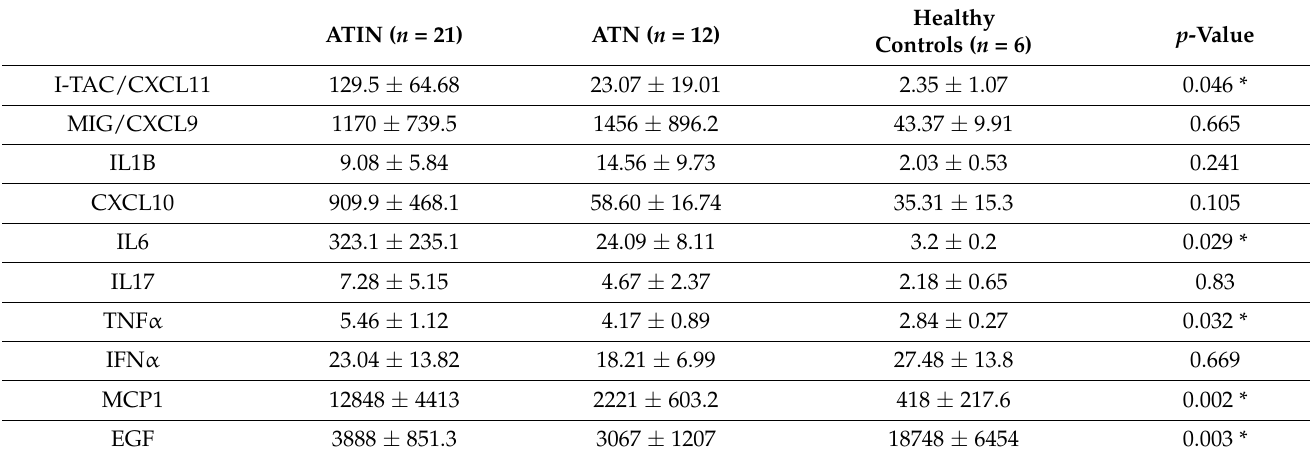
Table 2. ANOVA test comparing the urinary concentration of the evaluated cytokines in patients with ATIN, ATN, and healthy controls. * Statistically significant differences. ATIN—acute tubulointerstitial nephritis; ATN—acute tubular necrosis.